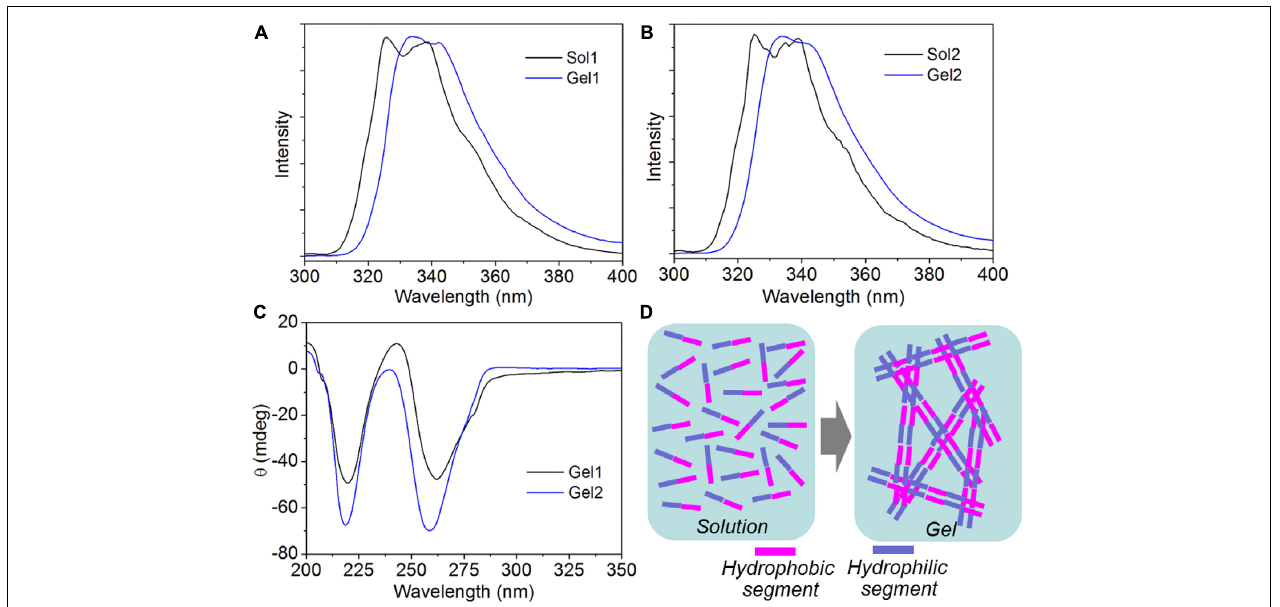
FIGURE 3 | (A,B) Fluorescent emission spectra of the solution of peptide 1 [Sol1, (A) ] and 2 [Sol2, (B) ], and their self-assembled hydrogels (Gel1 and Gel2). (C) CD spectrum of the supramolecular hydrogels self-assembled from peptide 1 and 2. (D) Schematic illustration of the self-assembly of peptide 1 and 2 into supramolecular